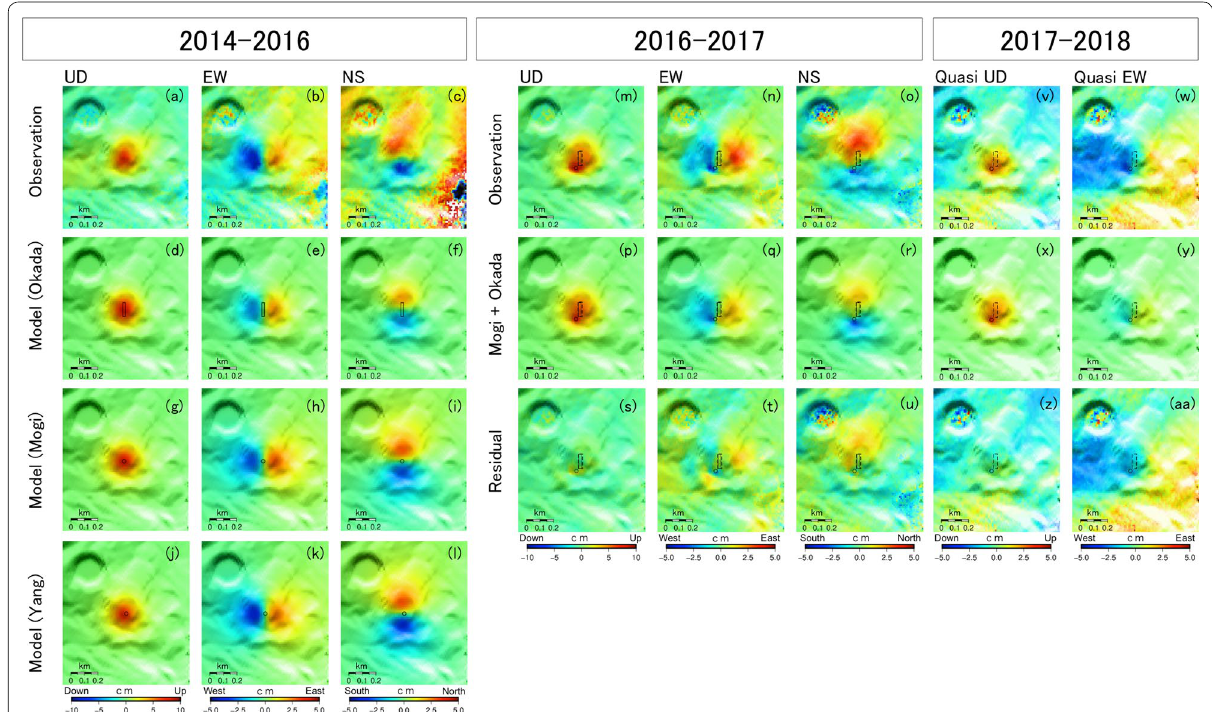
Table 3 Parameters of best-fit source models (2016—2018)